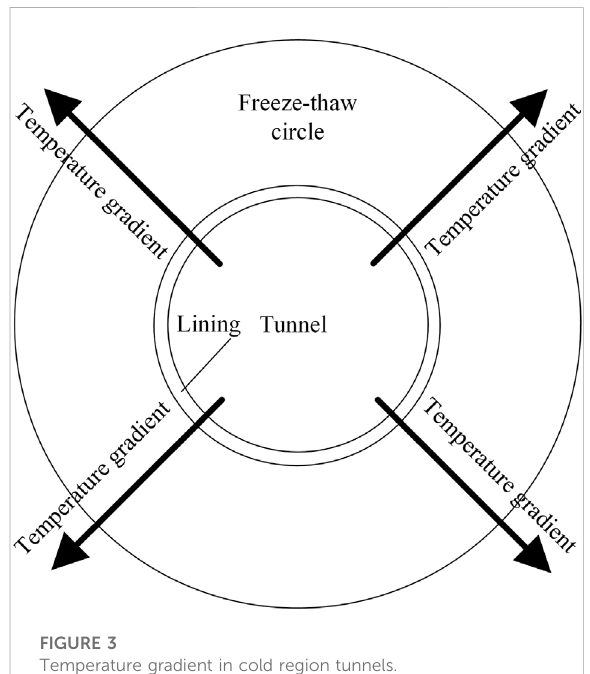
FIGURE 3 Temperature gradient in cold region tunnels.